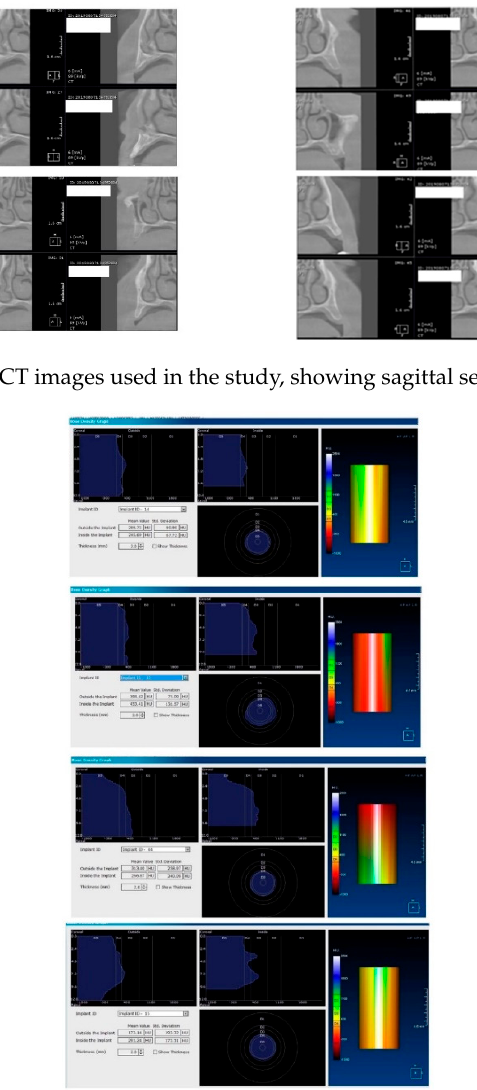
Figure 4. CBCT images used in the study showing the density of bone.